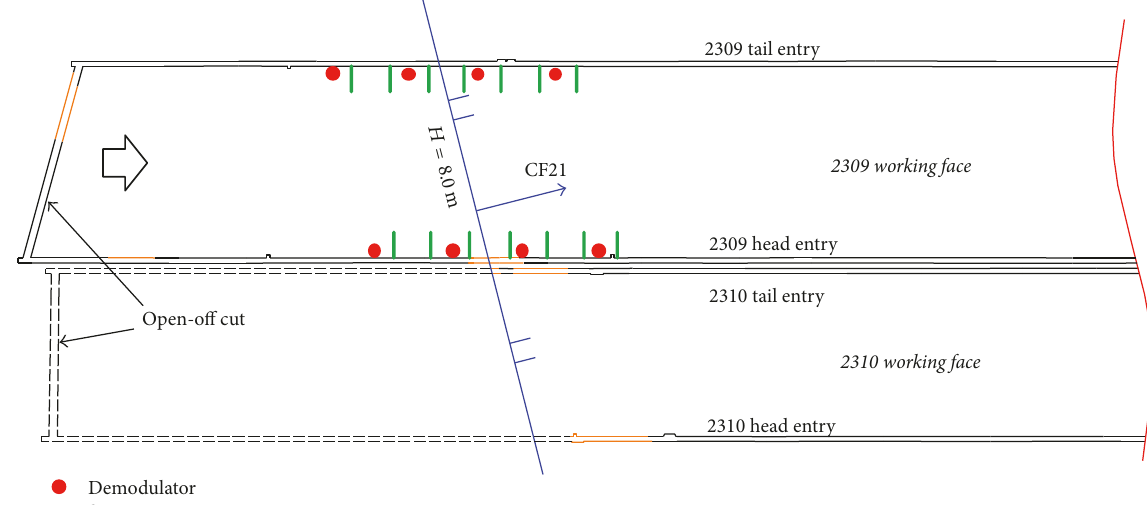
Figure 5: Geologic aspects of the working face and layout of monitoring